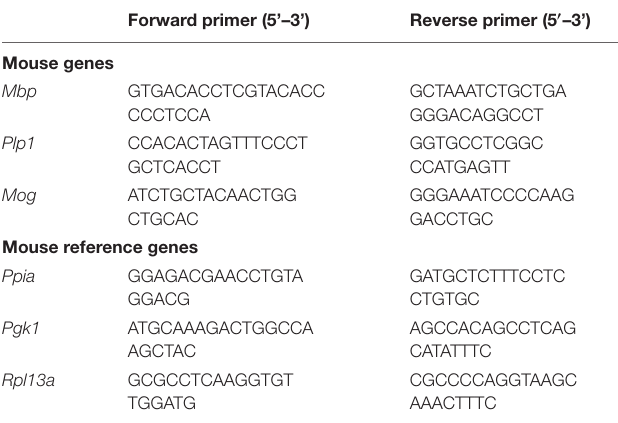
TABLE 1 | List of primer sequences used for RT-qPCR